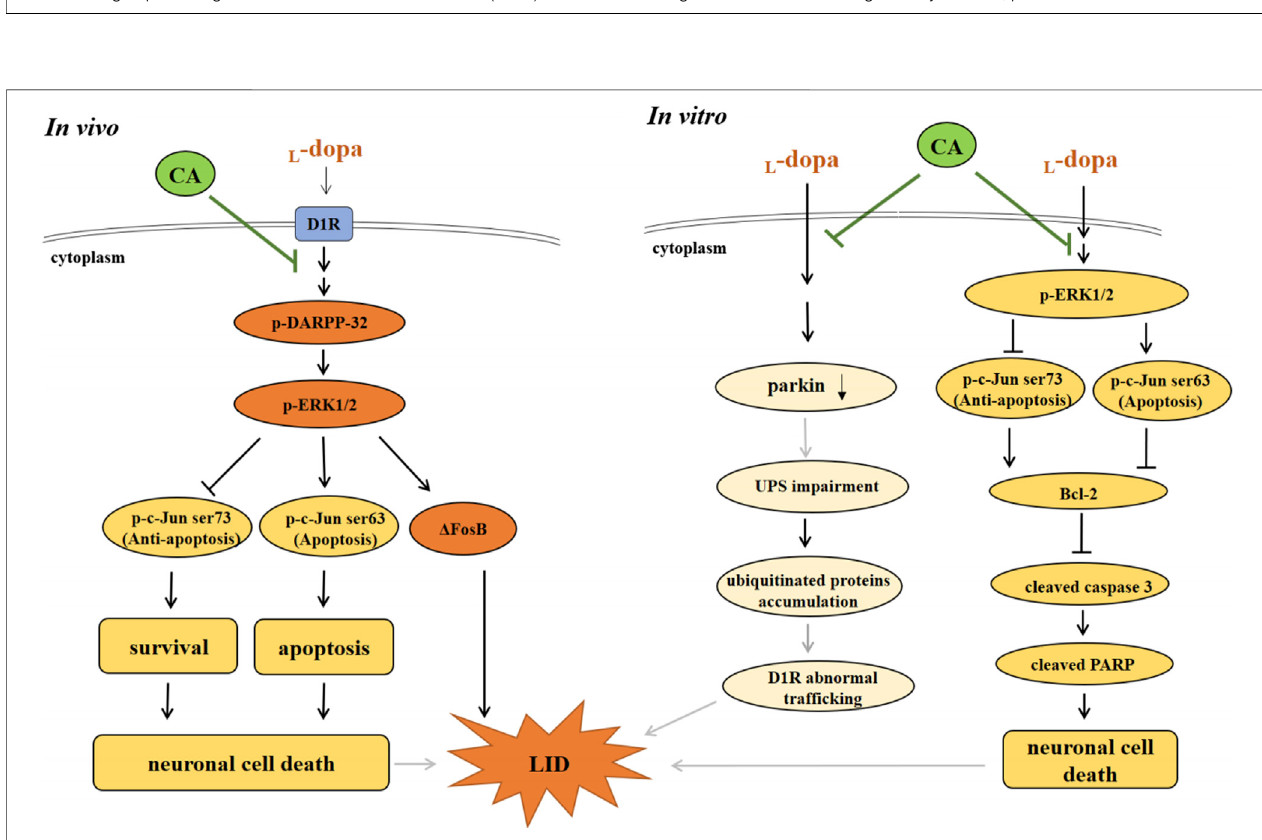
FIGURE 9 | The actions of neuroprotective mechanism of CA on LID in in vivo and in vitro studies. (A) In in vivo study, L -dopa stimulates DIR protein, and then activates the phosphorylation of DARPP-32 and ERK1/2, which elevates Δ FosB protein, leading to develop the LID in 6-OHDA-lesioned rats. Moreover, L -dopa administration induced neuronal cell death through regulating ERK1/2-c-Jun pathway. However, CA alleviates these effects induced by L -dopa. (B) In in vitro study, pretreatment of CA with SH-SY5Y cells attenuates L -dopa-triggered apoptotic cell death mediated via increasing c-Jun ser73 activation and decreasing c-Jun ser63 activation by ERK1/2. Additionally, CA could be improved the development of LID is related to the induction of parkin protein, leading to prevent the ubiquitinated protein accumulation and D1R abnormal traf fi cking (gray line).